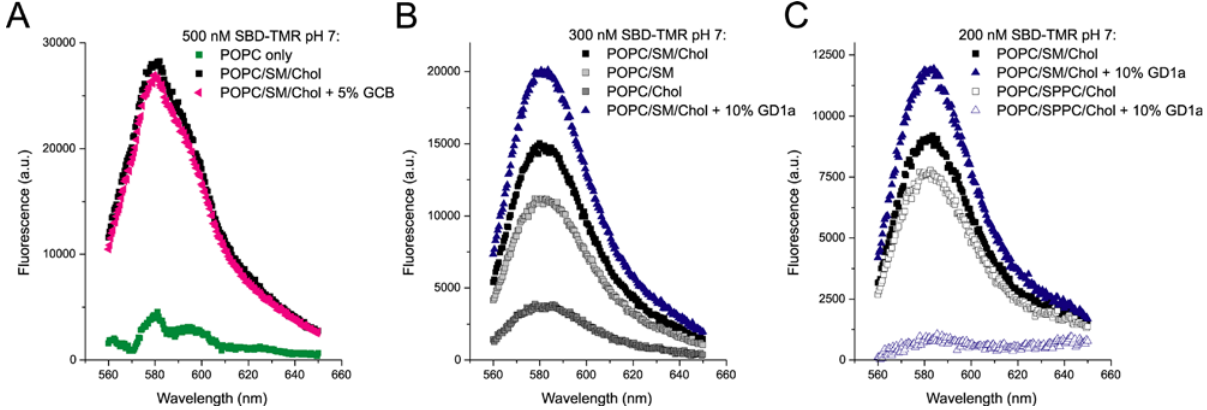
Figure 2. SBD binds preferentially to glycolipid-containing liposomes with raft-like composition. A. Fluorescence retained on liposomes of different composition after binding SBD-TMR to liposomes and filter-separation of unbound probe. SBD-TMR was retained much more strongly on liposomes containing the raft-like mixture of POPC:SM:Ch (45:25:30) (black squares) than on liposomes composed only of POPC (green boxes). Addition of 5% GCB (pink triangles), did not improve binding. B. A POPC/Chol (45:55) mixture (dark gray boxes) showed the lowest binding capacity, whereas a POPC/SM (45:55) mixture bound with intermediate affinity (light gray boxes). This was further improved by the presence of cholesterol (black boxes) and 10% GD1a (blue triangles). C. SBD shows some binding to the saturated glycerophospholipid SPPC, when substituted for SM in the basic raft mixture (POPC:SPPC:Ch 45:25:30) (white boxes). Unlike SM containing rafts, however, binding is abolished by addition of 10% GD1a (blue empty triangles). In all graphs, background fluorescence in the absence of liposomes, (e.g. due to possible retention of SBD in aggregated form) was subtracted. In POPC/SM/Chol liposomes, background fluorescence accounted for , 25% of total signal.